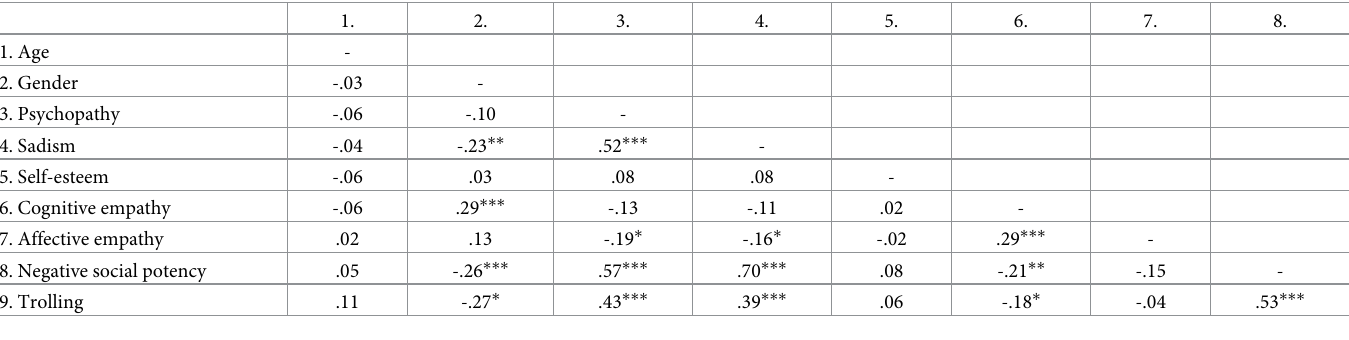
Table 3. Bivariate correlations for age, gender, psychopathy, sadism, self-esteem, cognitive empathy, affective empathy, and negative social potency, and